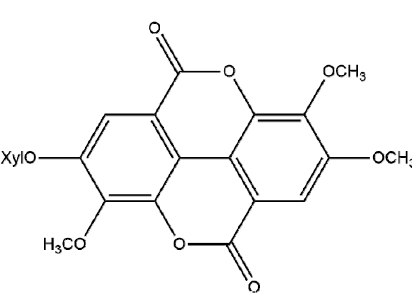
Figure 1. Structure of compound 1